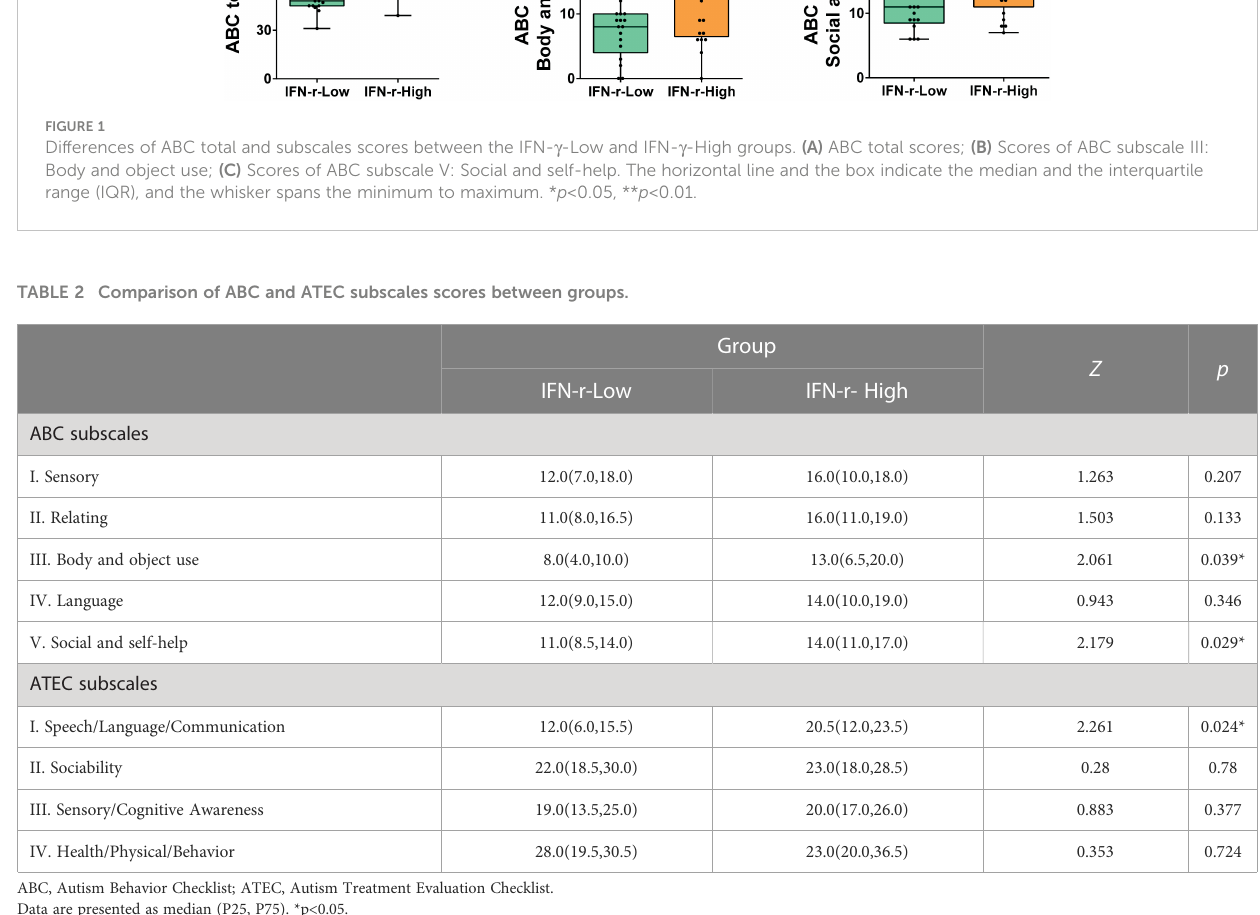
dissimilarityrevealed nosigni fi cantdifference between the two groups (Figure S3, PERMANOVA, r 2 = 0.0276, p = 0.398). The LEfSe method wasusedtodeterminethetaxaatdifferenttaxonomiclevelswhichwere